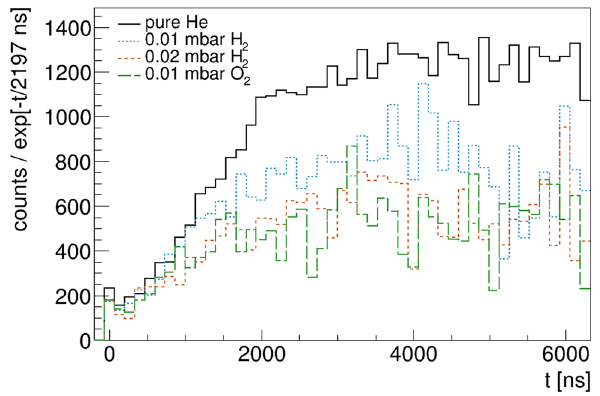
Fig. 7 Measured time spectra for 5 mbar pure He gas, and vari- ous admixtures of contaminants: (black) no additional contaminants, (dashed blue) 0.01 mbar H 2 , (dashed orange) 0.02 mbar H 2 , (dashed green) 0.01 mbar of O 2 . All data were normalized to the number of incoming muons and corrected for the finite muon lifetime by multi- plying the counts bt e t / 2197 ns